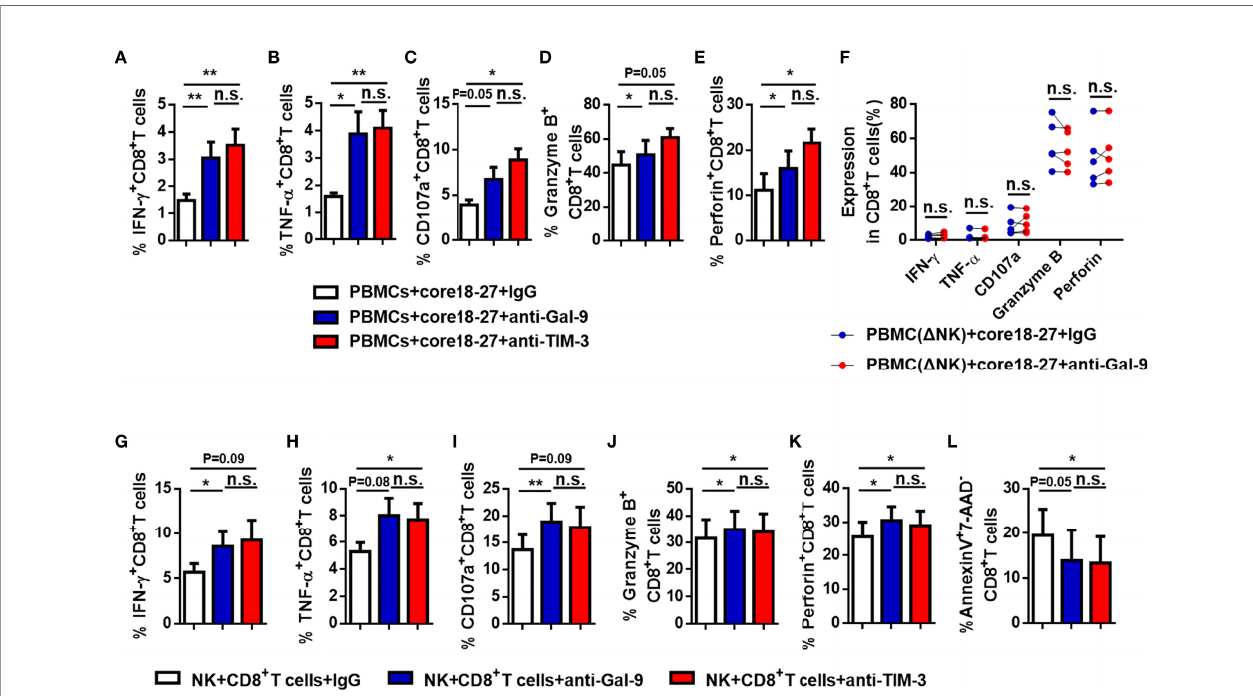
FIGURE 7 | The function of anti-HBV CD8 + T cells in active CHB patients was restored after blocking the Gal-9/TIM-3 pathway. (A-E) PBMCs isolated from active CHB patients were cultured in vitro with anti-human Gal-9 antibody, anti-human TIM-3 antibody, or control IgG and stimulated with HBV peptide (core18-27) for 10 days. The function of HBV-speci fi c CD8 + T cells was analyzed. (F) PBMCs depleted of NK cells (PBMCs- D NK) were cultured in vitro with anti-Gal-9 or control IgG and stimulated with HBV peptide (core18-27) for 10 days. The production of the cytokines IFN- g , TNF- a , CD107a, granzyme B, and perforin by CD8 + T cells was analyzed. (G – L) NK and CD8 + T cells were sorted from active CHB patients, cocultured in vitro with anti-human Gal-9 antibody, anti-human TIM-3 antibody, or control IgG and stimulated with anti-CD3/anti-CD28 for 3 days. The production of the cytokines IFN- g , TNF- a , CD107a, granzyme B, and perforin by CD8 + T cells (G – K) and early CD8 + T cell apoptosis (L) were analyzed. Results are expressed as the mean ± SEM, and the number of samples (n) in each group was ≥ 3. One- way ANOVA test was conducted for three-group comparisons. A paired t-test was used to compare paired samples. *P < 0.05; **P < 0.01; n.s., not signi fi